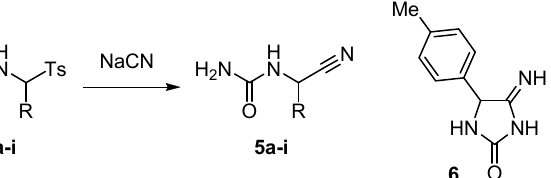
Scheme 4. Synthesis of α-ureido nitriles 5a-i by the reaction of N -(tosylmethyl)ureas 4a-i with so- dium